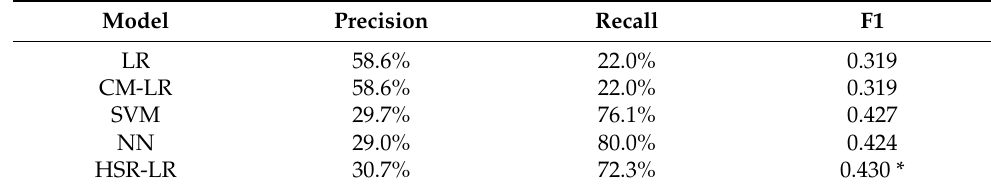
Table 7. Results on KC1.